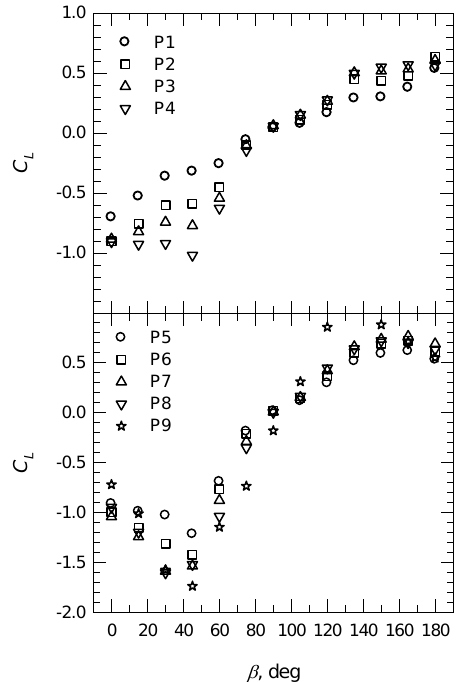
Figure 12. Lift coefficient. α : 0°  80°.